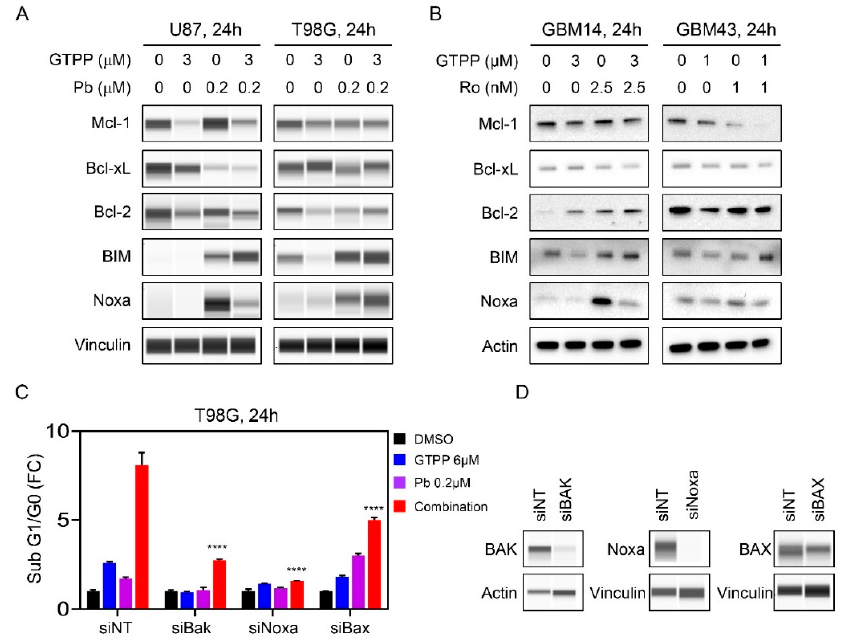
Figure 3. Rescue experiments demonstrate involvement of the Bcl-2 family members in cell death elicited by the combination treatment of gamitrinib and HDAC inhibitors. ( A ) U87 and T98G cells were treated with gamitrinib, panobinostat or the combination of both for 24h. Whole cell lysates were subjected for protein capillary electrophoresis. Vinculin serves as a loading control; ( B ) GBM14 and GBM43 cells were treated with gamitrinib, romidepsin or the combination of both for 24h. Whole cell lysates were subjected to standard western blotting. Actin is a loading control; ( C ) T98G cells were transfected with non-targeting (NT) siRNA, BAK, Noxa or BAX specific siRNAs. Following transfection, the cells were exposed to vehicle, gamitrinib (GTPP), panobinostat or the combination treatment of gamitrinib and panobinostat for 24h. Thereafter, cells were labeled with propidium iodide (PI) dye and analyzed by flow cytometry ( n = 3). Shown are means and SD. ( D ) Shown are protein capillary electrophoresis analyses of T98G cells transfected with the indicated siRNAs. ANOVA was used for statistical analysis. **** p < 0.001.